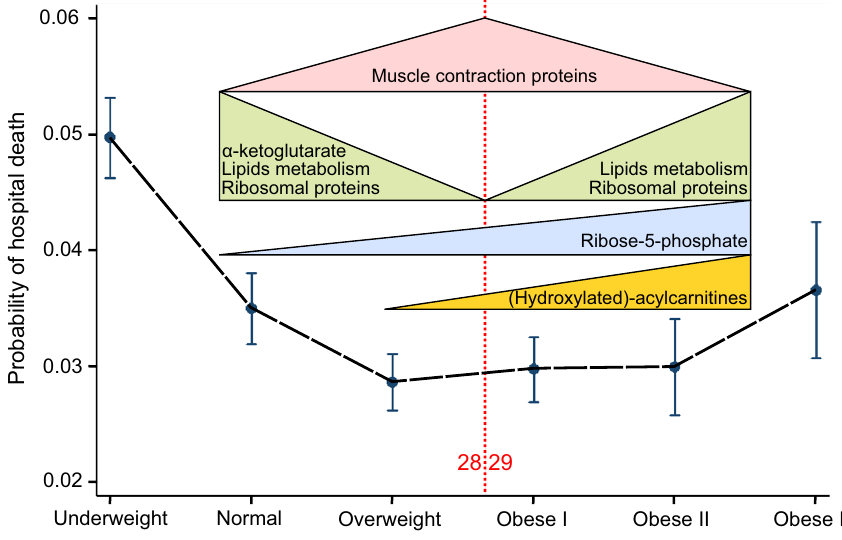
Figure 6. Summary of the results overlaid on probability of hospital death in WHO BMI groups 2